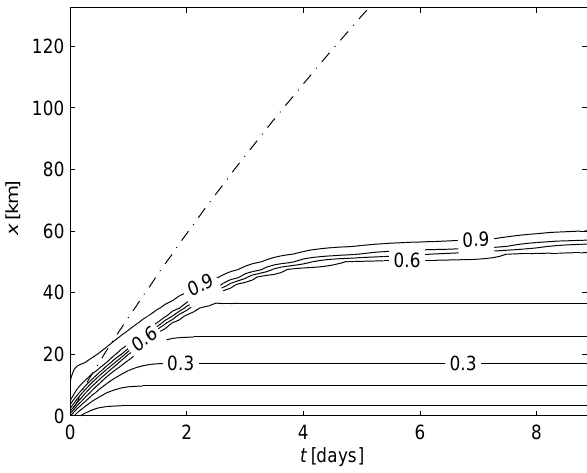
Fig. 4. A Hovm¨oller diagram of the ice concentration field ( A ) in the control experiment taken along a section at y =37.5km. The vertical axis ( x ) is the along-channel distance and the horizontal axis ( t ) is the model time. The dash-dotted line shows the h =1m isoline separating the thick initial ice and consolidated ice.